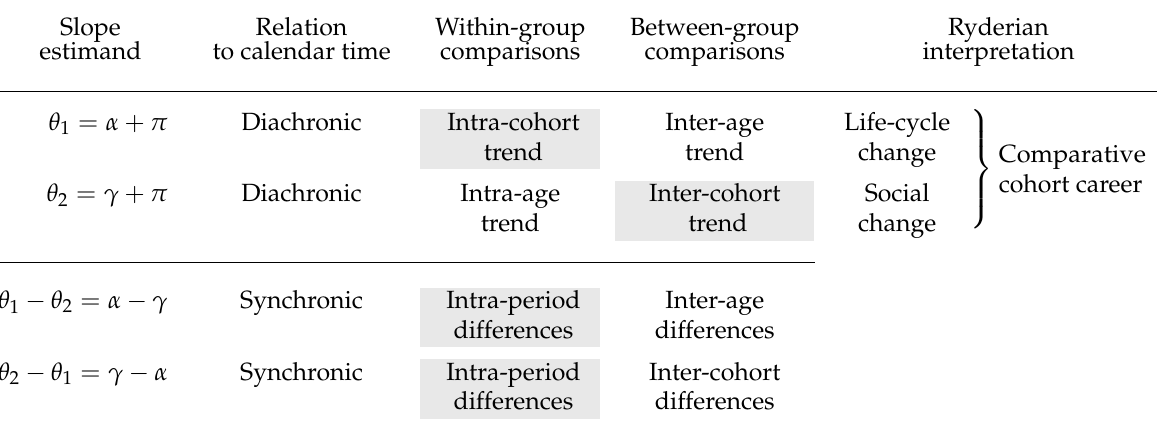
Table 1: Overview of diachronic and synchronic slope estimands